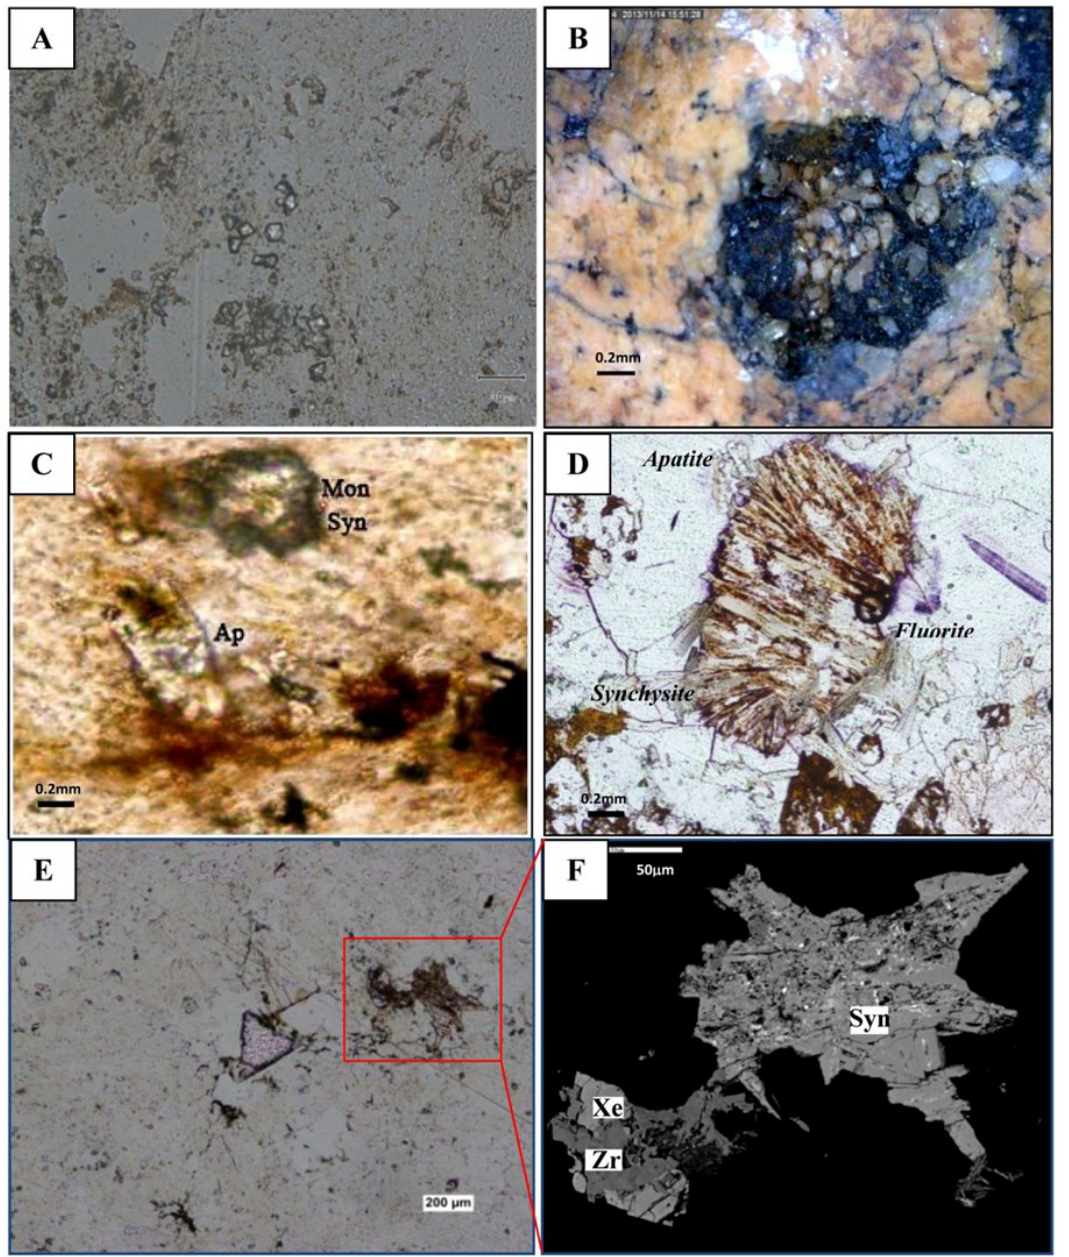
Fig. 9. Accessory minerals in alkaline dykes of the Khalzan complex. A. zircon grains, B. nests of zircon, C. apatite (Ap), monazite (Mon), synchysite (Syn), D. synchysite (Syn), fluorite, E. Goethite replaced by ore minerals with purple fluorite crystals, F. synchysite (Syn), zircon (Zr), Xenotime